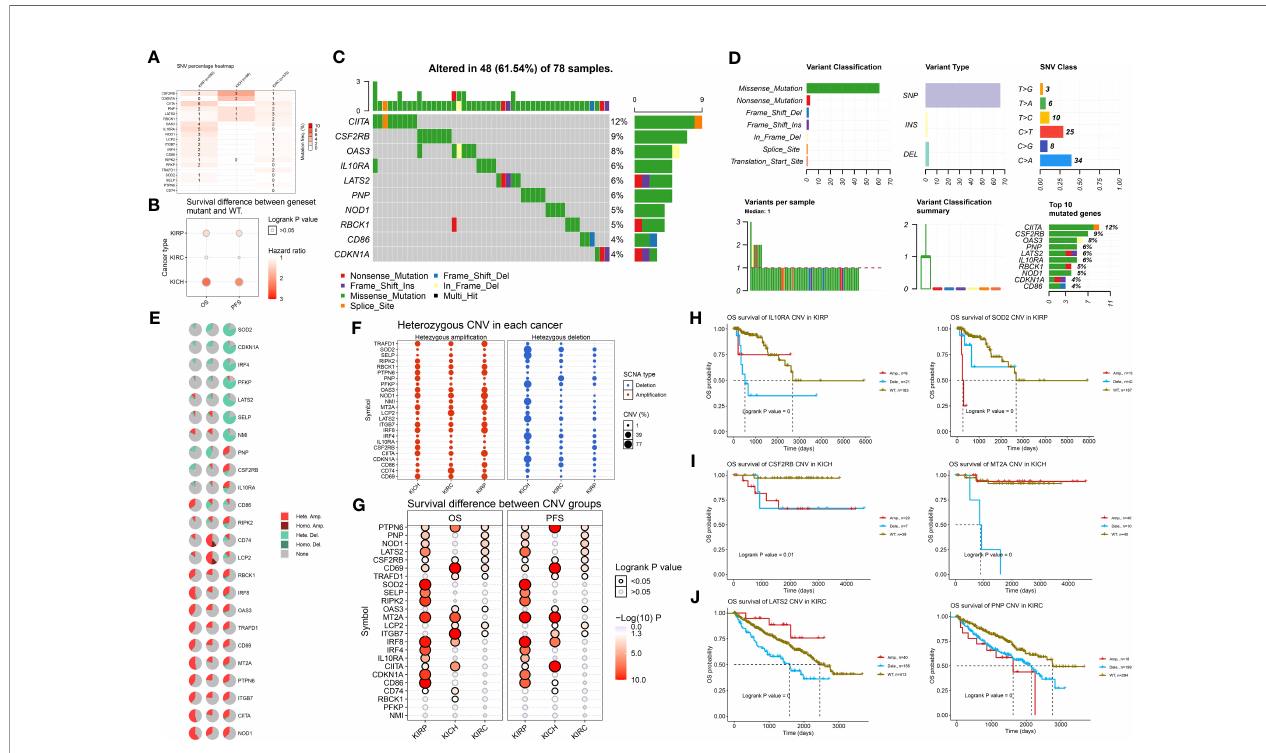
FIGURE 2 | DNA variation landscape of 24 IFN- g response signatures of RCC. (A) Pro fi les of SNV of the 24 IFN- g response signatures in ccRCC ( n = 370), pRCC ( n = 282), and chRCC ( n = 66) patients were provided. (B) Mutation of IFN- g response signatures was used to predict poor survival for patients with RCC. (C) Mutation information of IFN- g response signatures in 78 RCC samples with DNA variation was shown in the waterfall plot, where different colors with speci fi c annotations at the bottom meant various mutation types. (D) The variant classi fi cations, variant type, and SNV classes of IFN- g response signatures were summarized. A stacked bar plot shows the top 10 mutated genes. (E) Pie plot summarizes the CNV of IFN- g response signatures in patients with ccRCC, pRCC, and chRCC. (F) Using bubbles to represent the percentage of heterozygous CNV, including heterozygous ampli fi cation and deletion of IFN- g response signatures in ccRCC, pRCC, and chRCC. The bubble size is positively correlated with percentage; the bubble color blue represents deletion, and red represents ampli fi cation. (G) The hazard ratio and log-rank p -value through bubble color and size. The column is the gene set symbol and the row is the ccRCC, pRCC, and chRCC. The bubble color from blue to red represents the signi fi cance of log-rank p -value from low to high, and bubble size is positively correlated with the signi fi cance of log-rank p -value. (H – J) Kaplan – Meier curves between ampli fi cation, deletion, and wide type of the 24 IFN- g response signatures in ccRCC, pRCC, and